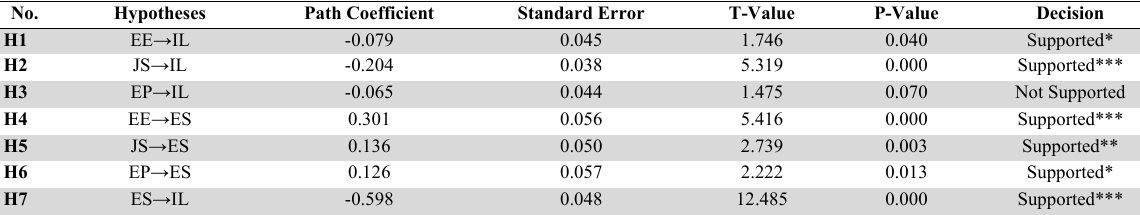
Results of the Structural